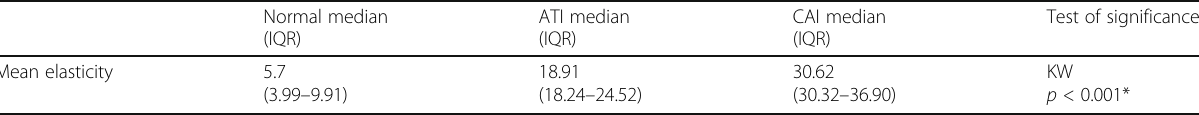
Table 3 Mean elasticity among studied groups